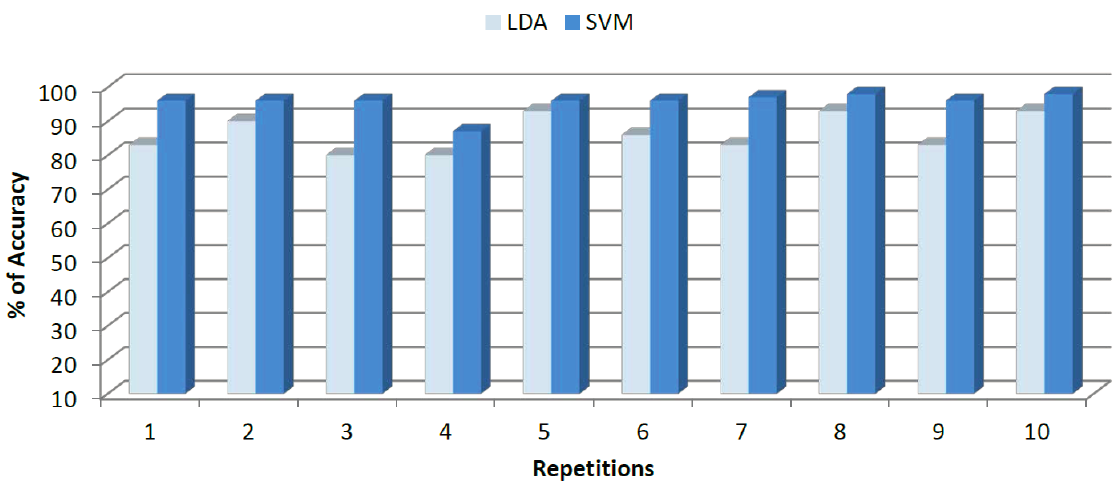
Figure 6. Final results obtained for growing conditions classification after k -fold cross-validation data using LDA and SVM models.